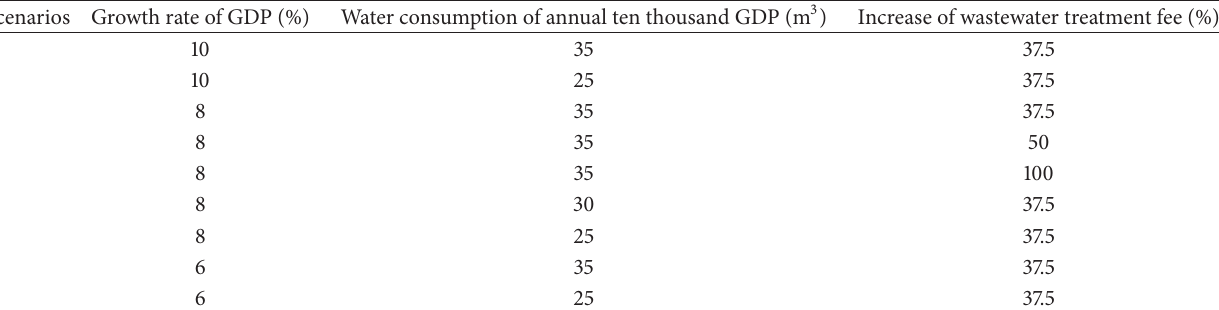
Scenarios Growth rate of GDP